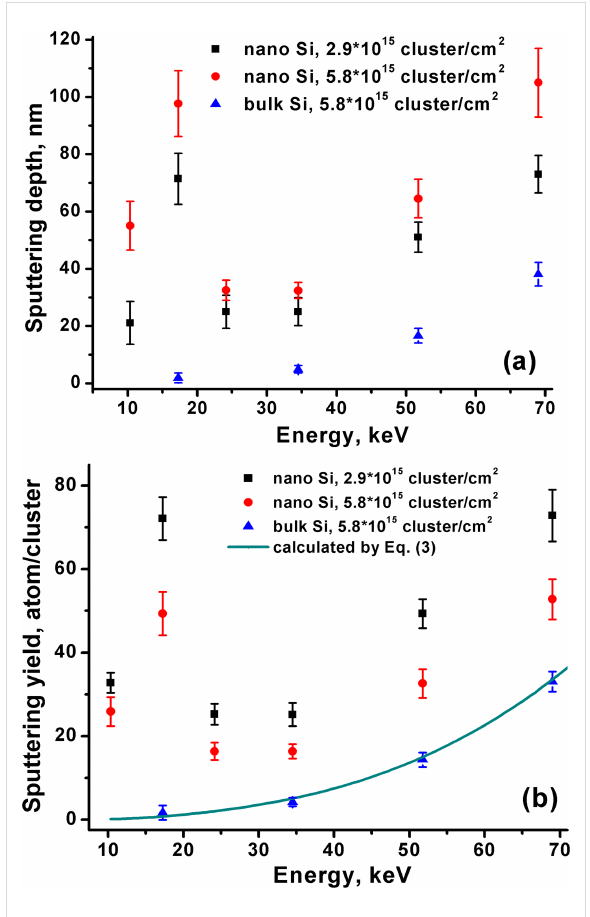
Figure 6: The sputtering depth (a) and sputtering yield (b) depen- dence of the Si nanopowder and bulk Si on energy at different ion doses. The sputtering yield of the bulk Si is fitted to the curve de- scribed by Equation 3.